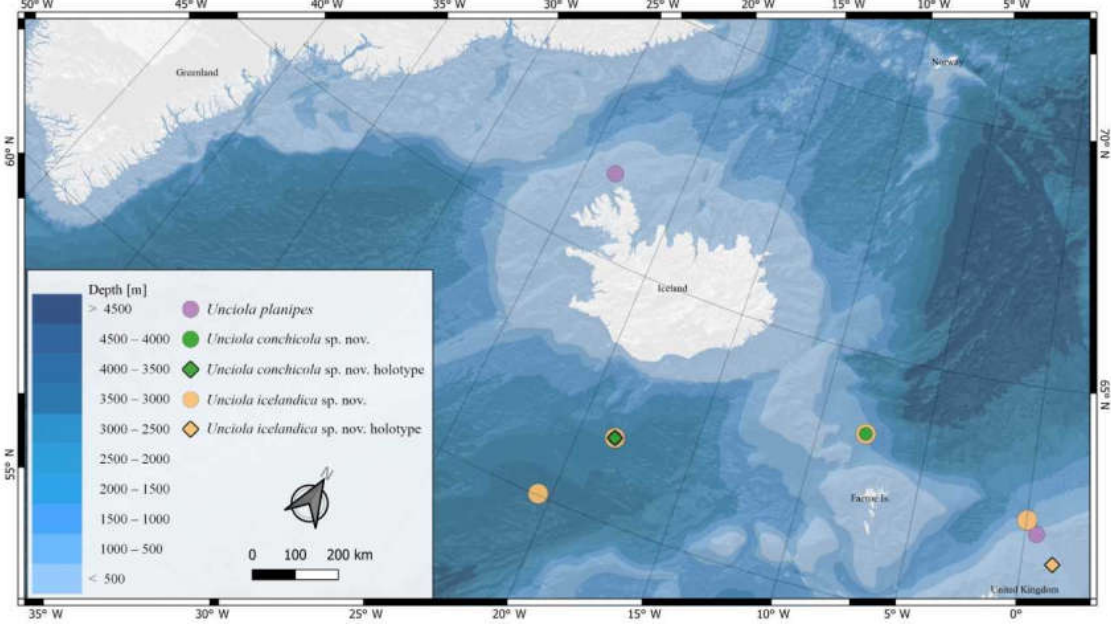
Figure 1. Locations of Unciola species found in the North Atlantic based on the material collected during IceAGE expeditions.